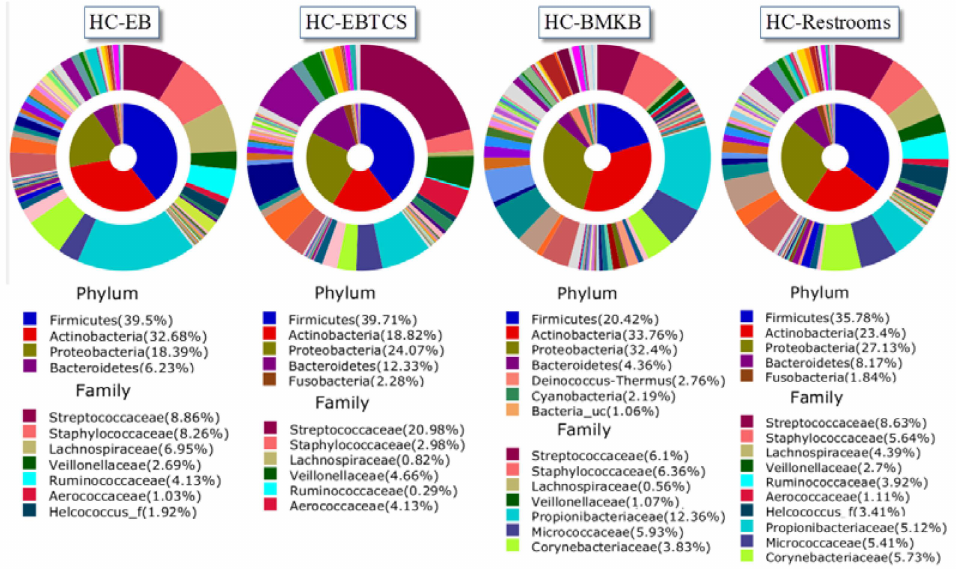
Figure 2. Average composition of bacteria from each sample (inner area: Phylum, outer area: Family). Only bacterial phyla and families that had a relative abundance of 1% or greater are